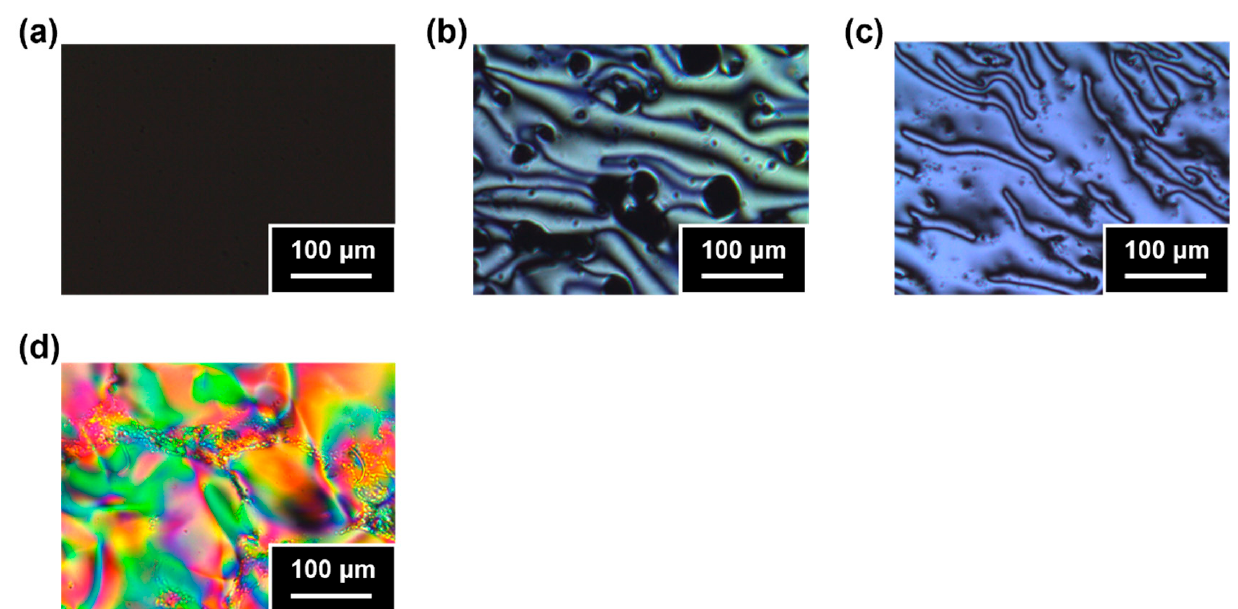
Figure 10. Polarized optical microscopic images of the pQpdS-Na/ H 2 O mixtures in the 100–X:X weight ratios. ( a ) X = 95 at 25 °C, ( b ) X = 90 at 25 °C, ( c ) X = 85 at 25 °C, and ( d ) X = 80 at 25 °C.